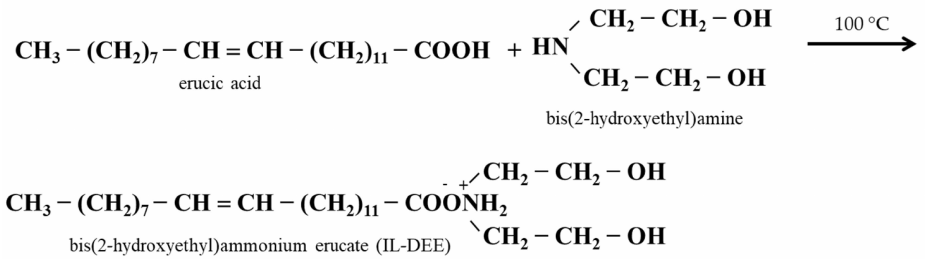
Figure 2. Scheme of bis(2-hydroxyethyl)ammonium erucate formation.